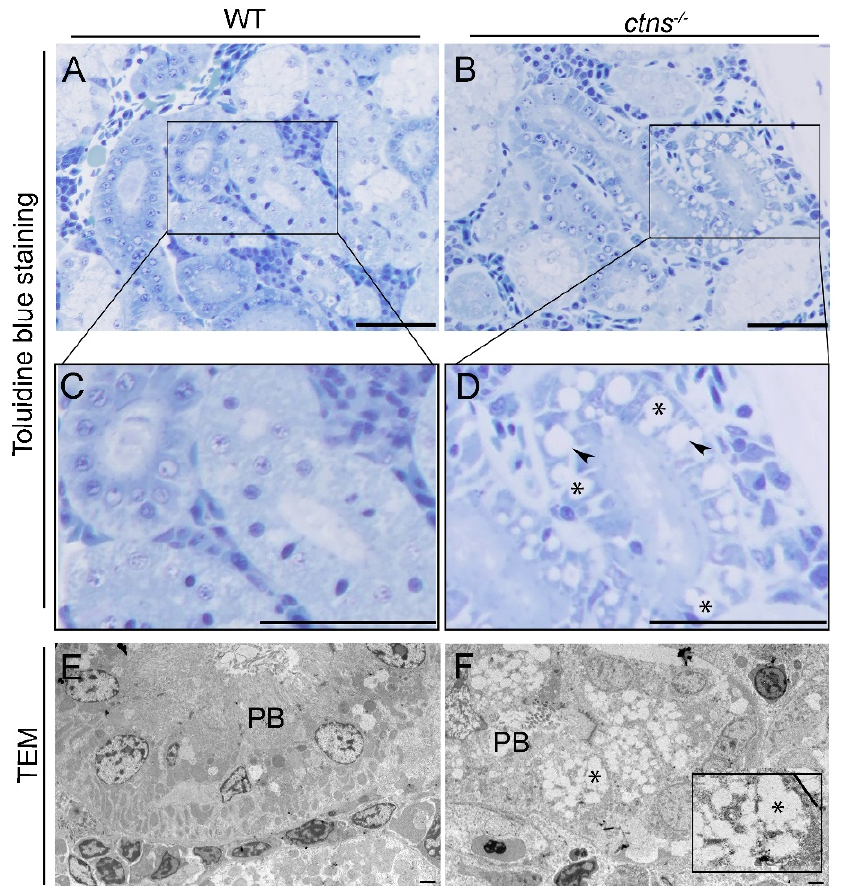
Figure 3. Kidney cystine crystals in wild-type and ctns − / − zebrafish PTECs. ( A , B ) Representative toluidine blue-stained images of renal proximal tubules in wild-type ( A ) and ctns − / − ( B ) 18-month- old zebrafish. The scale bars represent 50 µ m. ( C , D ) Figure 3C,D show a higher magnification of Figure 3A,B. Details of renal proximal tubules with cytoplasmic vacuoles (( D ); *), rectangular and polymorphous vacuolar spaces (( D ); black arrowheads). ( E , F ) Representative TEM images of the renal proximal tubule of wild-type ( E ) and ctns − / − 18-month-old zebrafish ( F ). ( F ) Partial loss of proximal tubule brush borders (PB) and accumulation of the rectangular and polymorphous vacuoles (*) were observed in the renal proximal tubule of ctns − / − zebrafish. The high-magnification view of the rectangle in the bottom right corner shows the polymorphous vacuoles and a large vacuole with straight membrane border segments (a straight line). The scale bars represent 5 µ